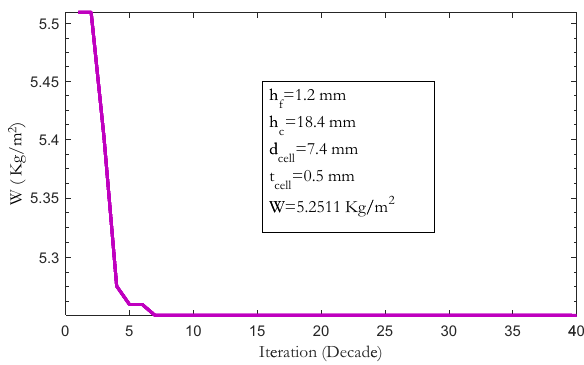
Figure 6: Convergence of the ICA to the optimal solution for a sandwich beam without FR additives